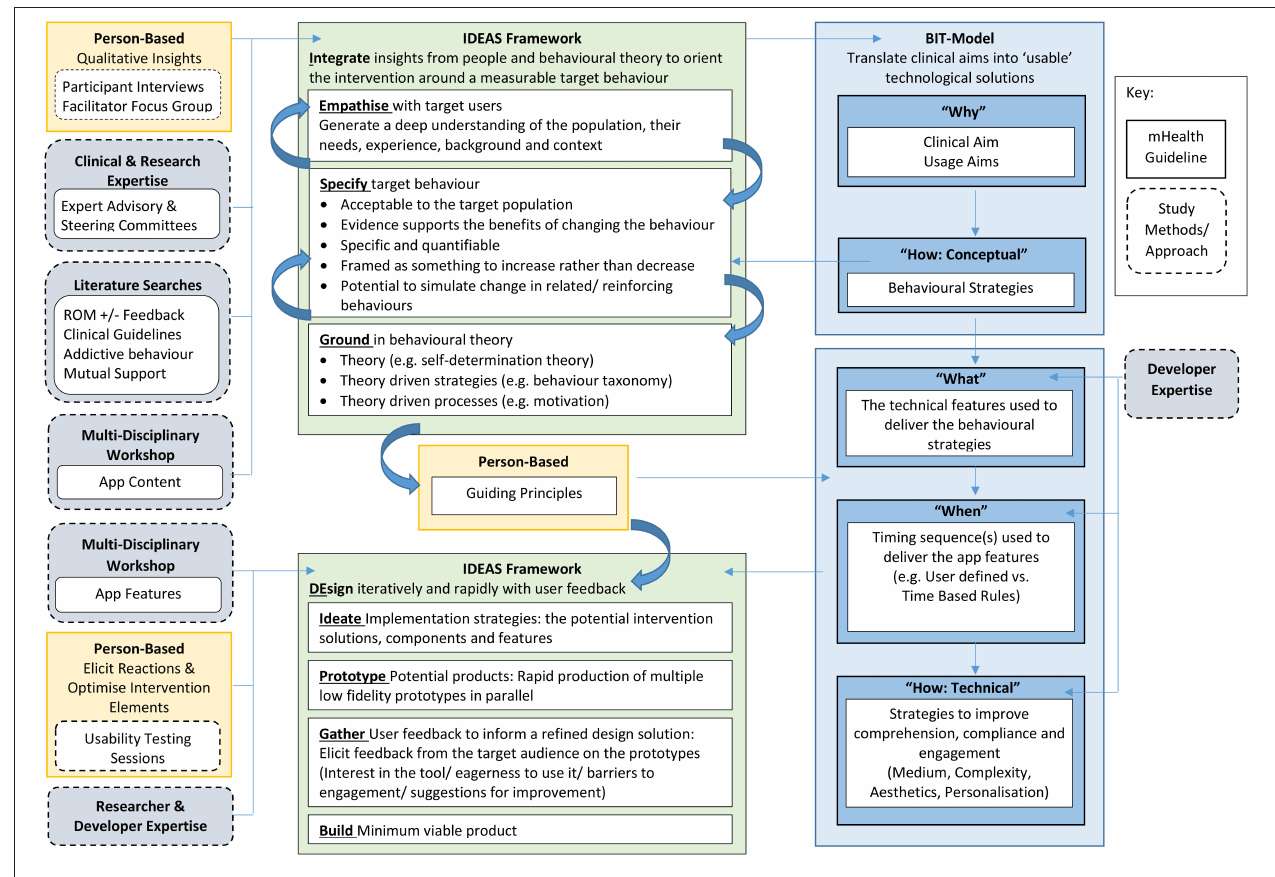
FIGURE 1 | Integration of Person-Based, BIT Model, and Ideas